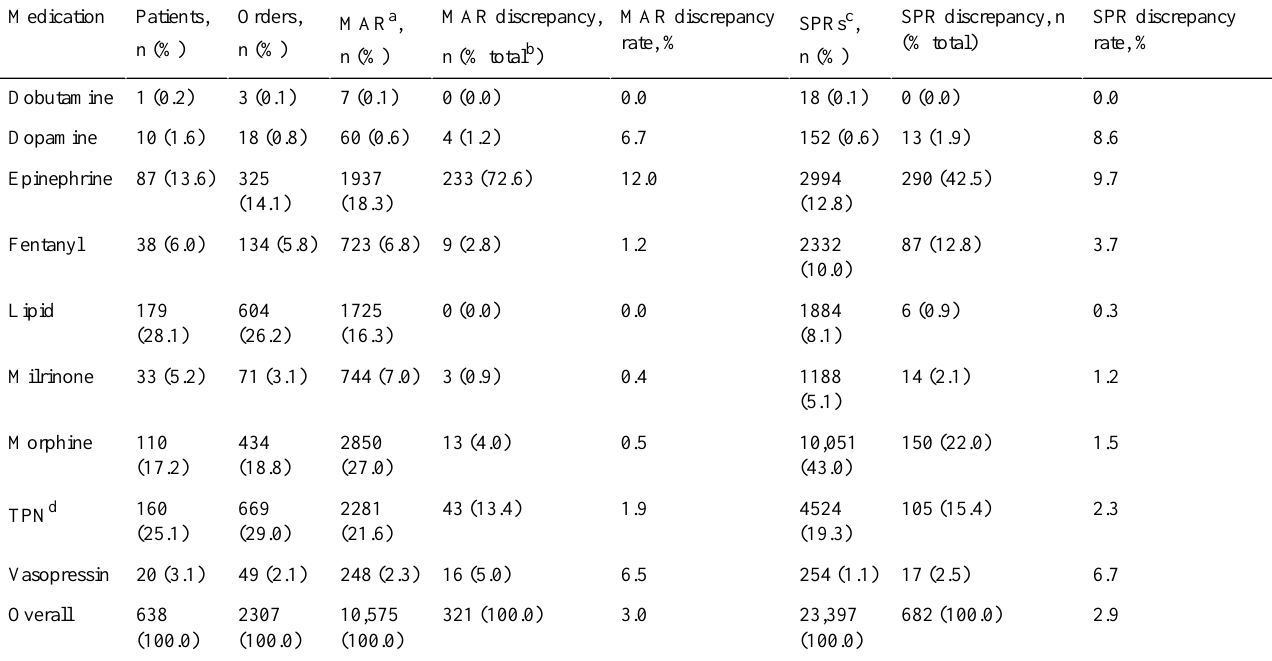
Table 3. Descriptive statistics of the gold standard medication use data.